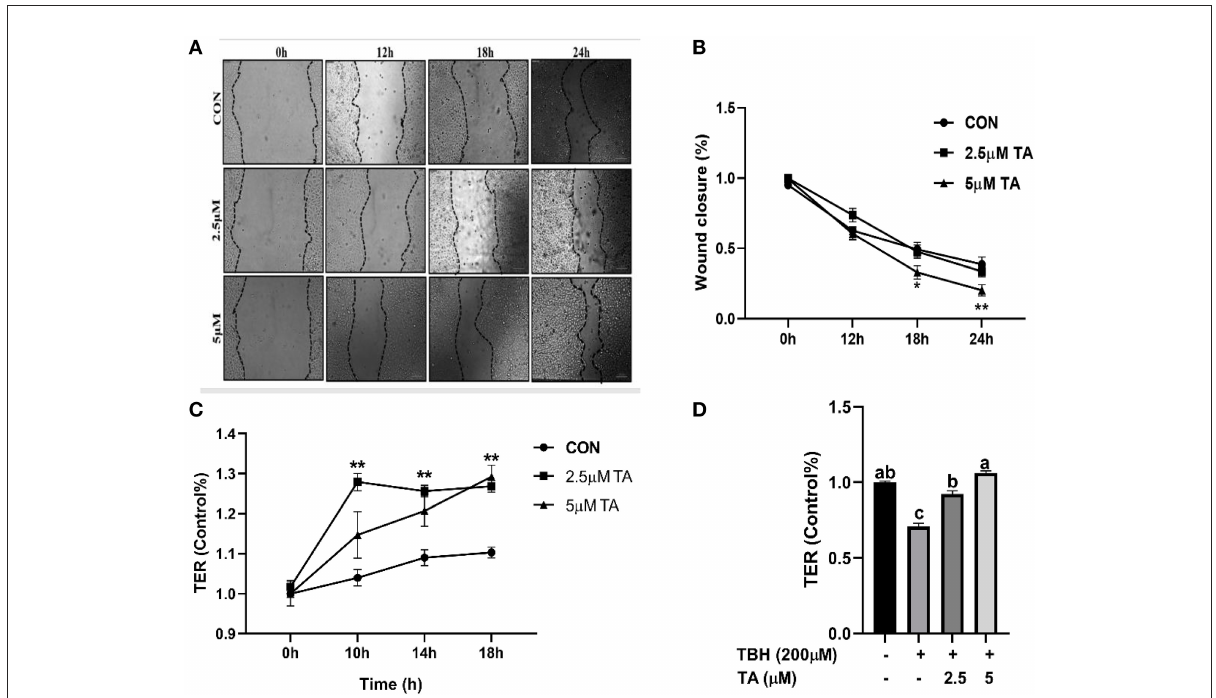
FIGURE6 Effects of tannic acid (TA) on wound healing and transepithelial electrical resistance (TER) of IPEC-J2 cells. The representative images of wound healing at 100 × magnification (A) . Quantitative analysis of the width of wound (B) . Effect of TA on the TER value in IPEC-J2 cells (C) . Effect of TA on the TER value in TBH-treated IPEC-J2 cells (D) . Data are presented as mean ± SEM, n = 3. a,b values in the same row not sharing a common superscript differ significantly. TA, tannic acid; TBH, tert-butyl hydroperoxide. * P < 0.05, 0.01 < ** P <